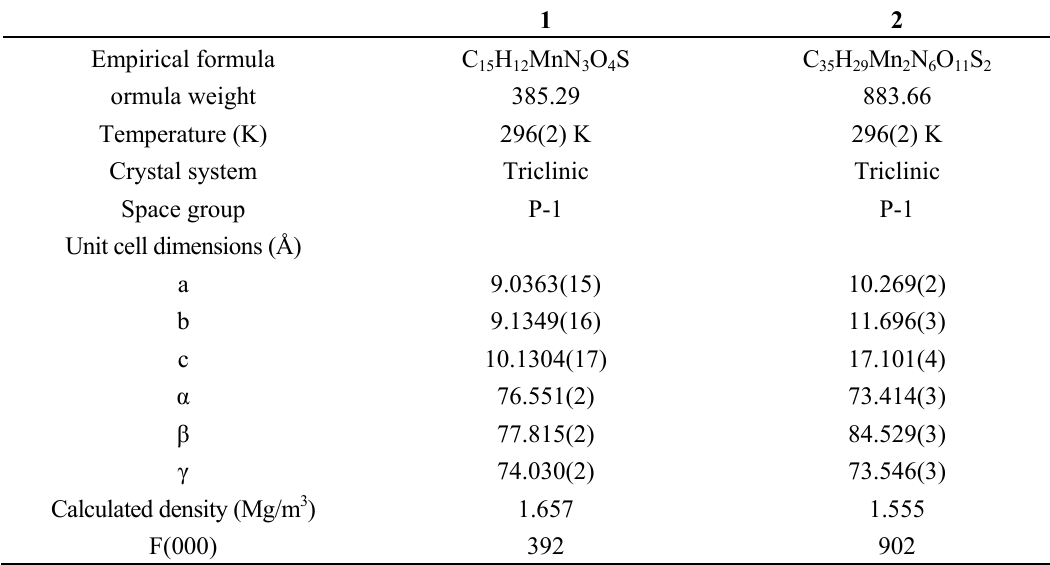
Table 1. Crystal data and structure refinements for 1 – 2